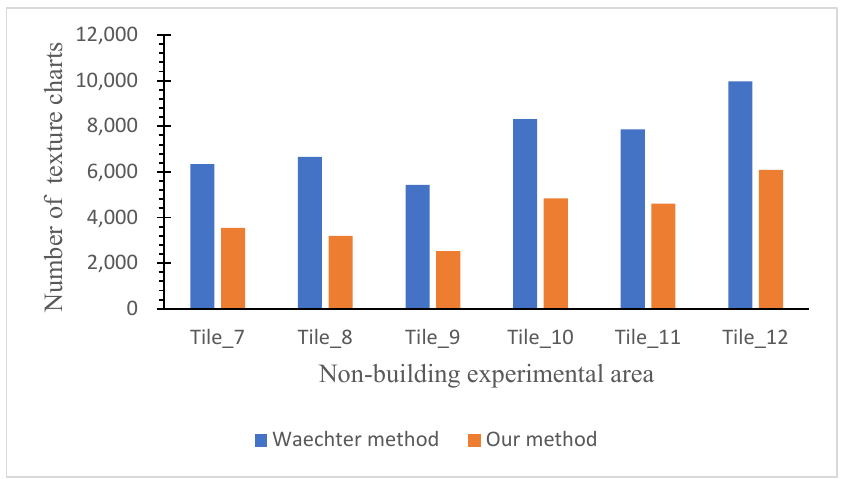
Figure 19. Bar graph for the number of texture charts with debris in the nonbuilding experimental area comparison.